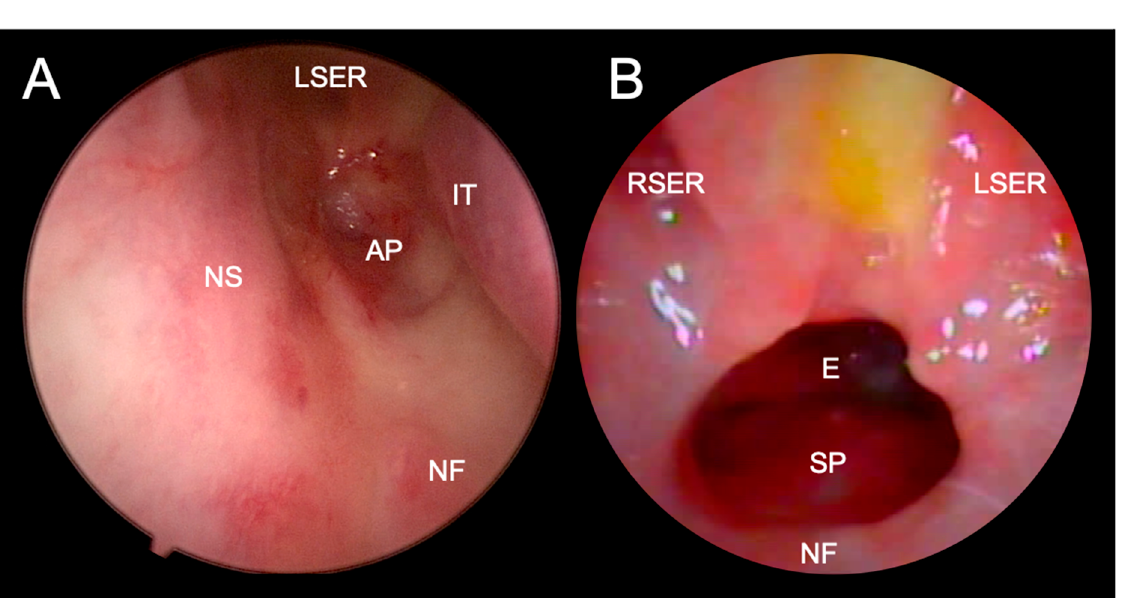
Figure 8. Endoscopic visualization of complete restenosis after transnasal perforation ( A ) and good patency of unichoana four weeks after transnasal endoscopic choanoplasty ( B ) of bilateral choanal atresia. A trace of milk and mucus is visible between the two sphenoethmoid recesses in Figure B, suggesting a significant influence of gastric contents reflux on the operative wound healing. LSER - left sphenoethmoid recess; RSER–right sphenoethmoid recess; IT–inferior turbinate; AP–atretic